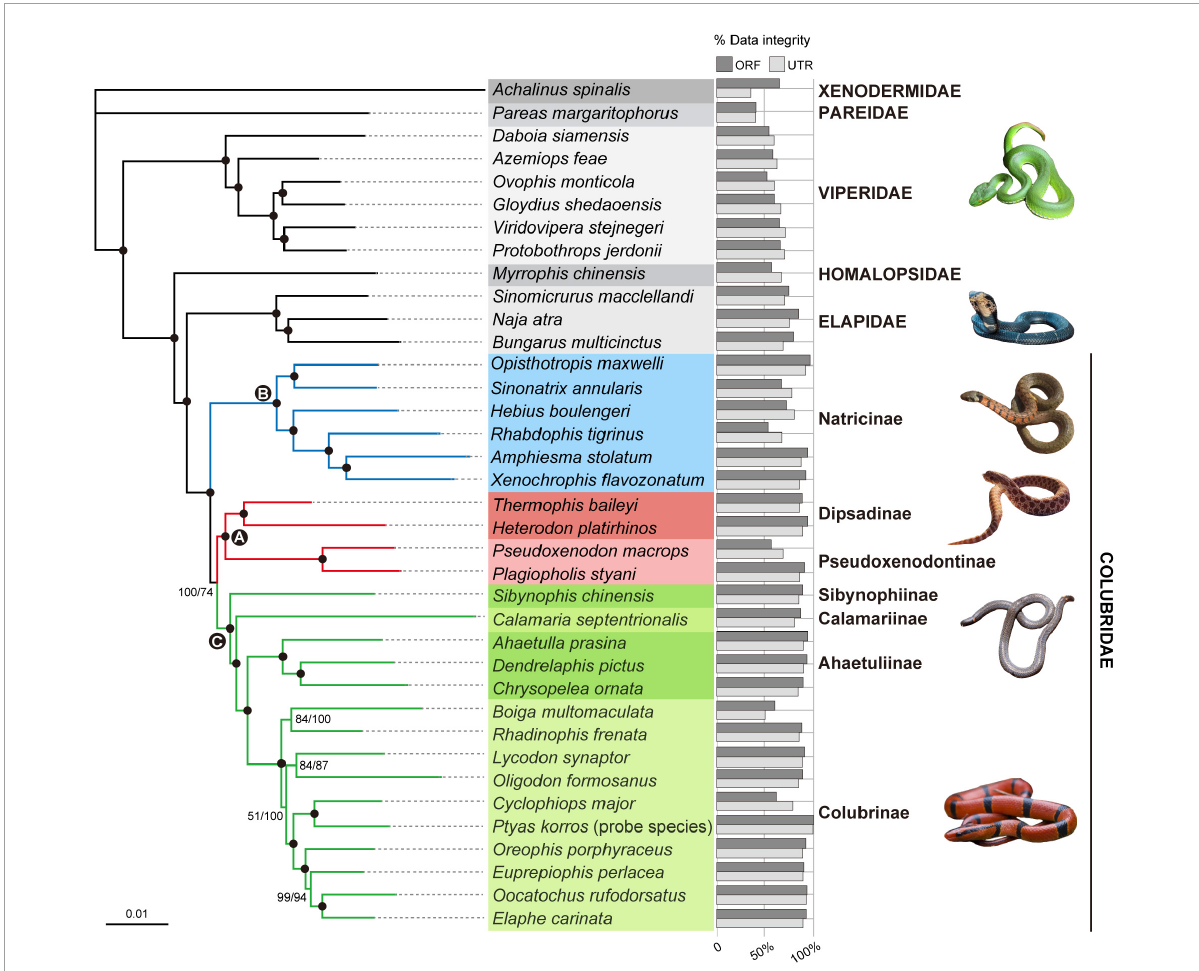
FIGURE6 Phylogenetic relationships among the 25 Colubridae species (including the probe species Ptyas korros ) and 12 outgroup species inferred from the ORF (1,075 ORFs; ∼ 817 K) and UTR (1,948 UTRs ∼ 1,114 K) data sets. The trees are inferred with RAxML, and the two data sets produce identical phylogeny. Branch support values are indicated beside nodes in order of ORF ML bootstrap and UTR ML bootstrap from left to right. The filled circles represent ML bootstrap support ≥ 95% (both ORF and UTR). The three hotly debated nodes (A–C) within the Colubridae family are indicated by filled circles with letters. The bars right to the species name represents the integrity of the data set for each species (calculated by